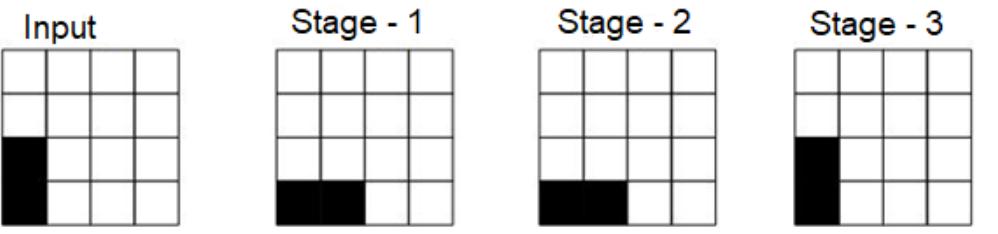
Figure 6. Conversion of the difference through three basic operations.